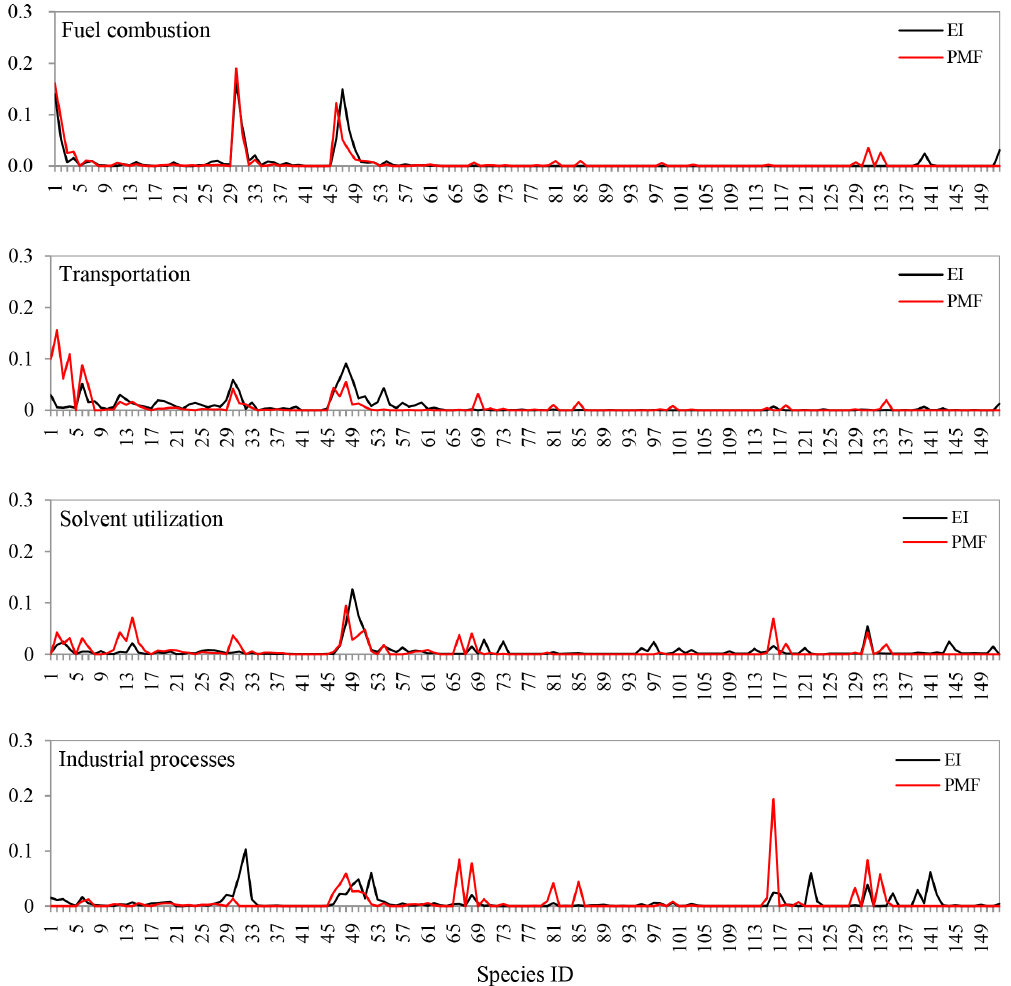
Figure 8. Source profiles for VOCs calculated by PMF and the emission inventory (species names were shown in Table